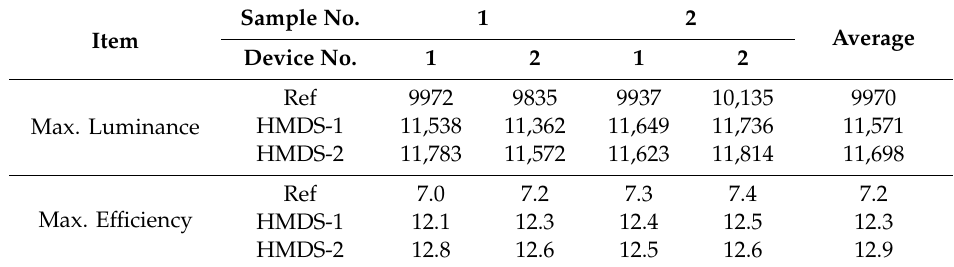
Table A2. The maximum luminance and e ffi ciency for each condition. (Measurement of four devices from two samples.)